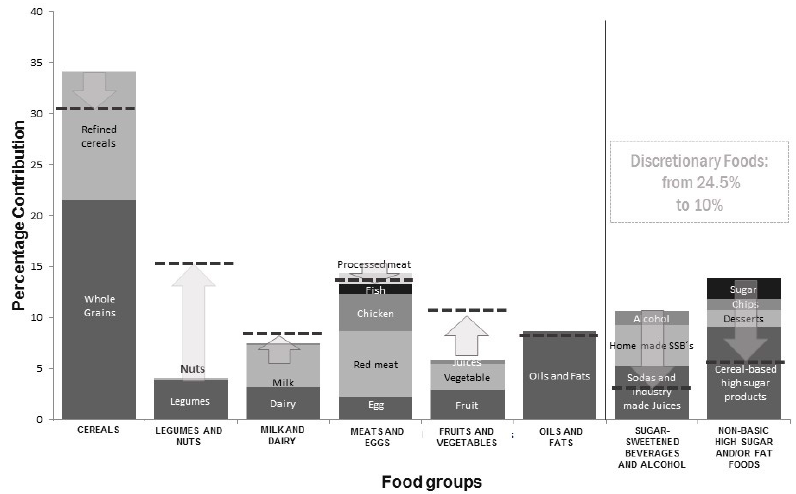
Figure 5. Dietary goals for Mexico based on the contribution of food groups to total energy intake (adults).